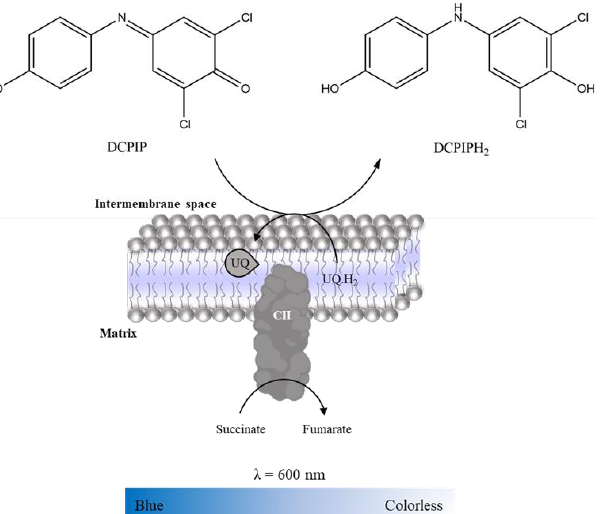
Figure 8. Reduction of DCPIP with color change from blue to colorless, used as an exogenous acceptor of electrons resulting from succinate oxidation to fumarate promoted by Complex II. Table 6. Conditions and flow setup for Complex II activity assay.